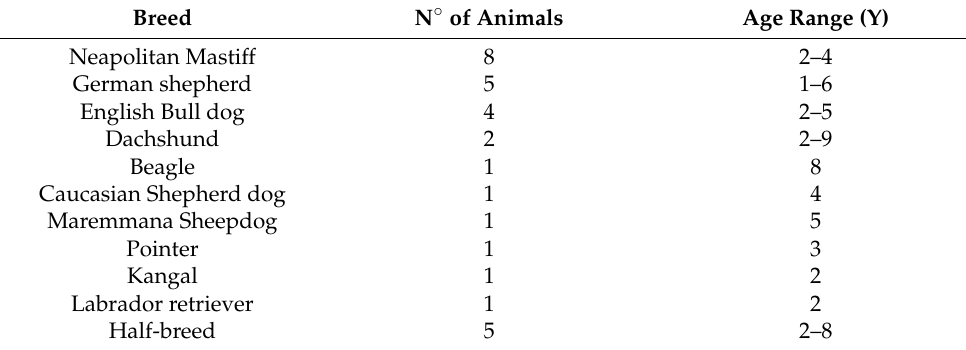
Table 1. Breed and age of the analyzed dogs. (Y = year). Breed N ◦ of Animals Age Range (Y) Neapolitan